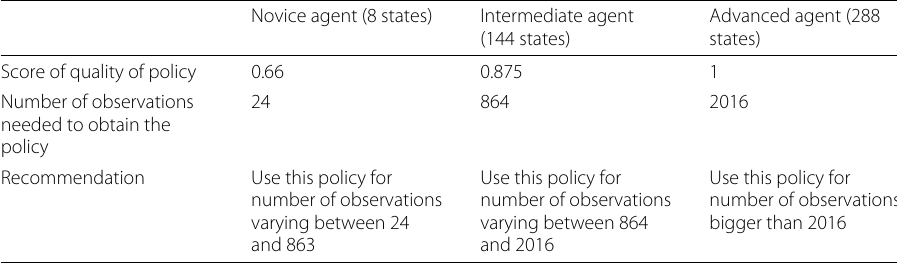
Table 6 Summary and